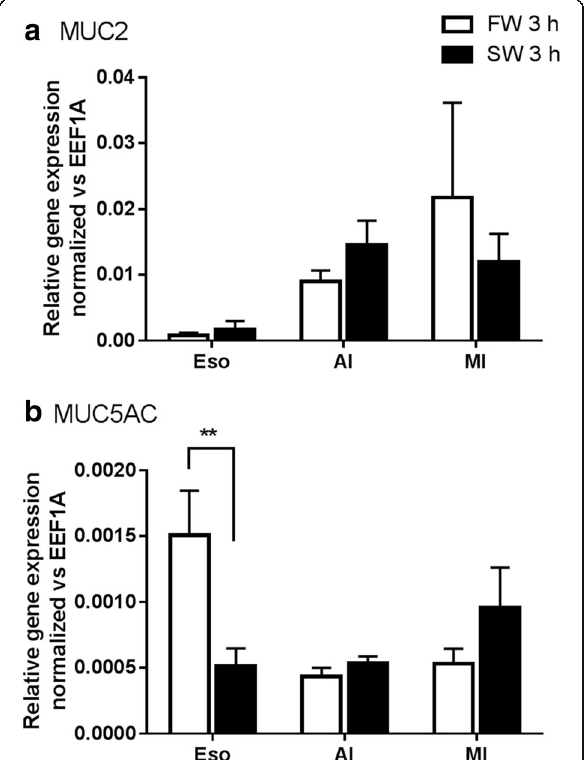
Fig. 8 Effects of FW-FW and FW-SW transfer on the mucin gene expressions. a MUC2 and b MUC5AC in esophagus (Eso), anterior (AI), and middle (MI) intestines ( N = 5). Statistical difference between salinity transfer in the same tissue is indicated by ** ( p < 0.01) after two way ANOVA, Bonferroni ’ s